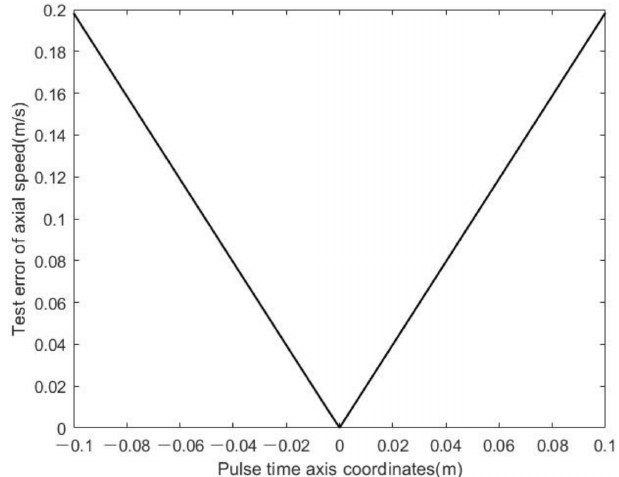
Figure 3. Influence of pulse-time axis coordinate on axial-velocity measurement error.